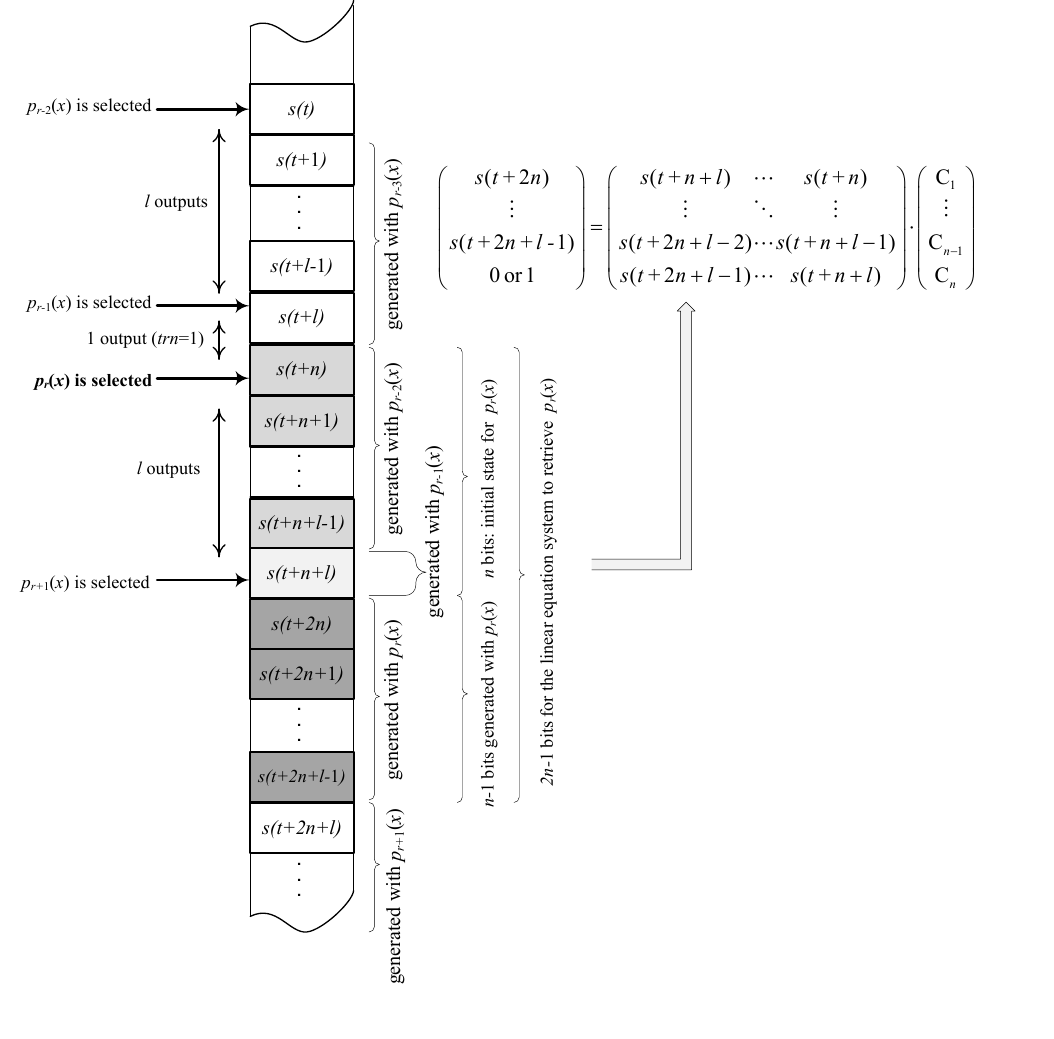
Figure 2. Sketch of the linear equation system